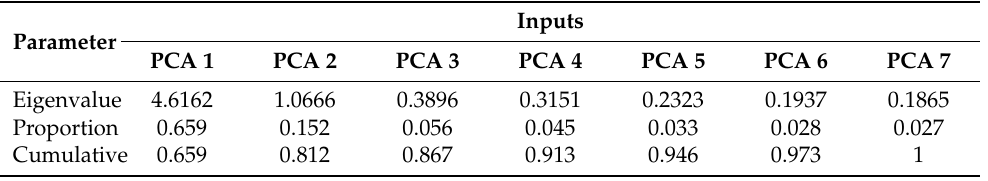
Figure 4. Density diagram of the input parameters using PCA.